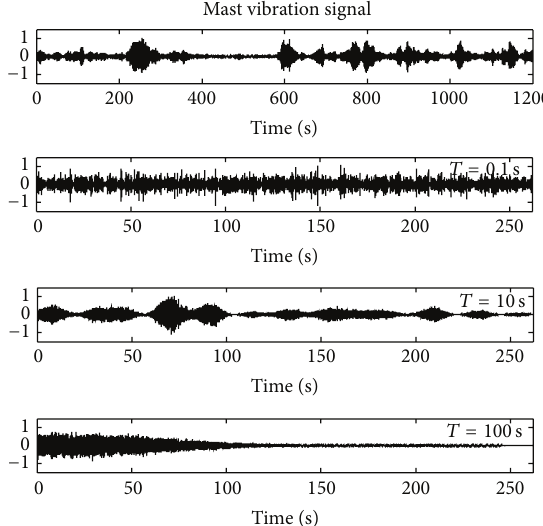
Figure10:NumberofcyclesversusdatarangesforRFCCandDirlik.